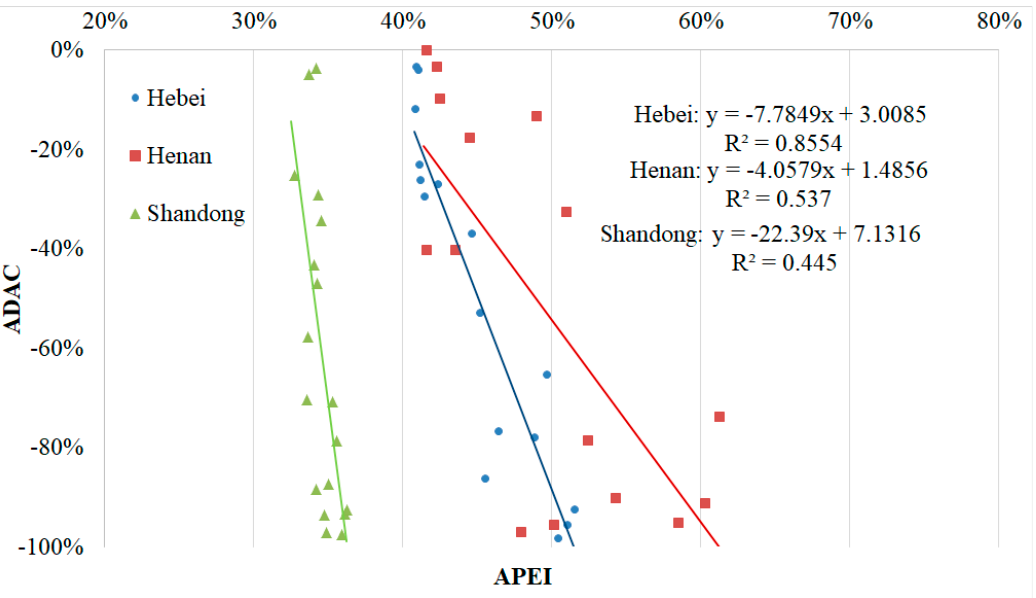
Figure 4. Scatter plots of the relationship between the agricultural drought-affected area changes (ADAC) of crop land and Area Percentage Equipped for Irrigation (APEI) during the period of 1981–2000 for Hebei, Henan and Shandong Provinces.